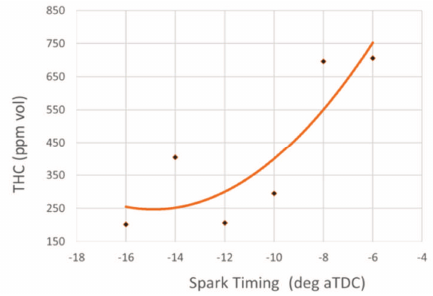
Fig. 6. THC emission as a function of the spark timing